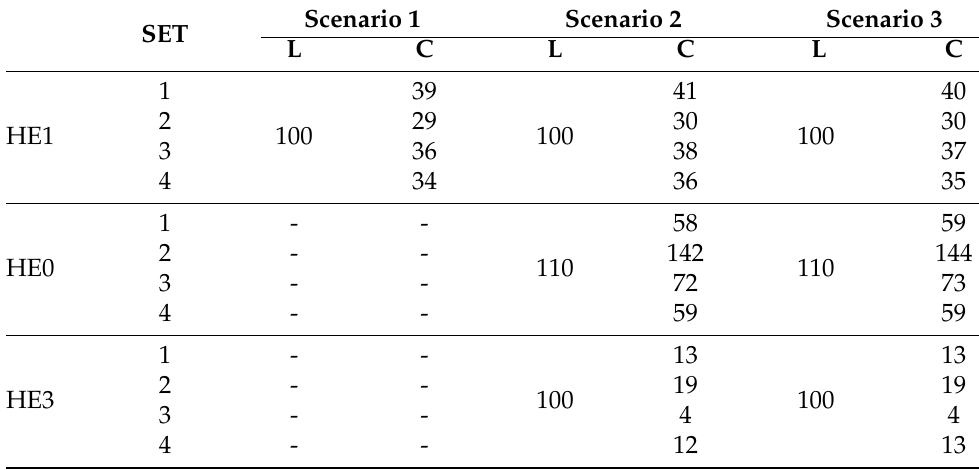
Table A1. The lines (L) and columns (C) of the air-to-air heat exchangers.